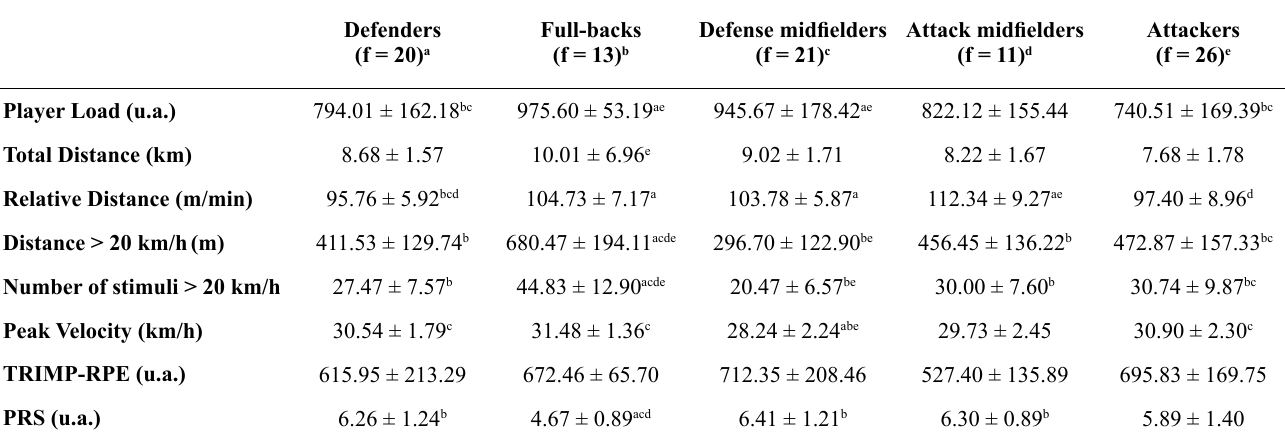
Table 1. - Comparison of external and internal load and recovery by playing position.